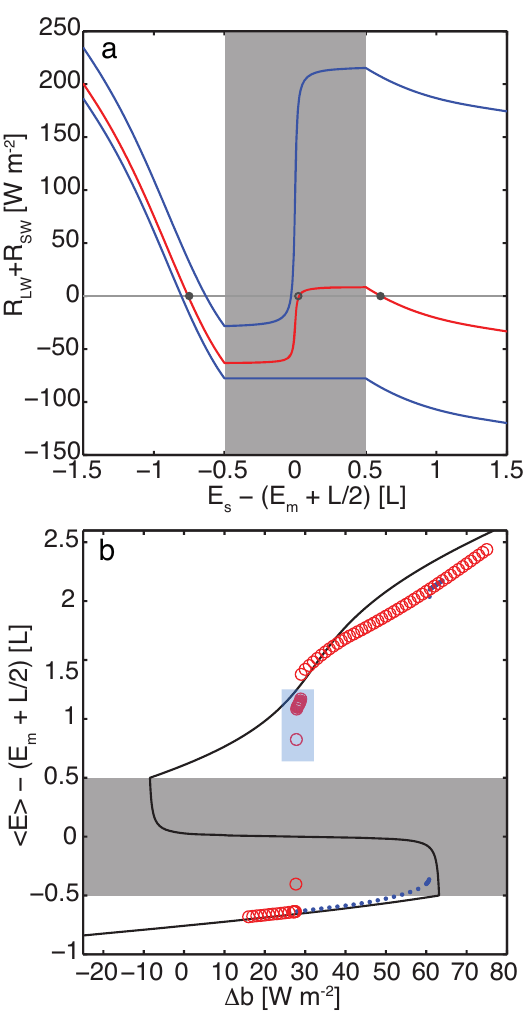
Fig. 4. (a) Surface energy budget R SW + R LW versus surface cell energy for 1b = 0, α I = 0 . 85, α W = 0 . 07, and the albedo parame- terization in Eq. (3): annual maximum values (upper blue), annual minimum (lower blue), and annual averages (red). The zeros of the surface drives are marked by the horizontal line; the symbols indi- cate the fixed points resulting from the annual average surface drive. (b) Hysteresis of the average cell energy h E i as a response to vary- ing atmospheric forcing 1b . Simulations with an initially ice cov- ered state (blue dots) started with a uniformly frozen ice-ocean layer [ E − (E m + L/ 2 ) = − 0 . 61 L for all cells], and simulations with an initially open water state (red circles) started from a uniform water layer [ E − (E m + L/ 2 ) = 0 . 85 L for all cells]. The ice cover is sea- sonal within a narrow range of forcing 1b (shaded blue), if started with an open water initial condition. For comparison, the zeros of the annual average surface energy budget R SW + R LW are plotted as a function of 1b (black graph). In both graphs the energy scale is centered around the phase transition (Eq. 2). Energies within − 0 . 5 L and 0 . 5 L (grey area) correspond to the melting point temperature, i.e., they represent the absorption/release of latent heat of that cell.